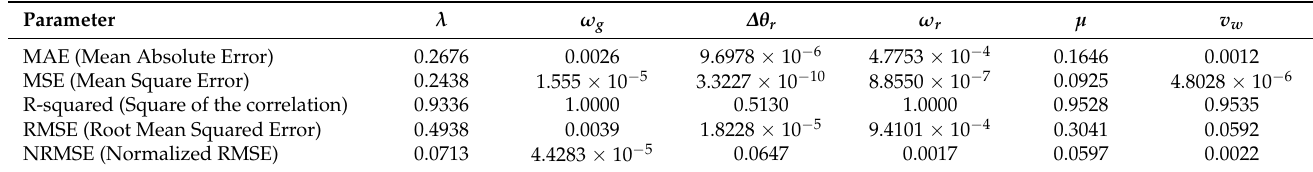
Figure 15. Time series of the rotor speed. Table 4. Quantitative evaluation of the model and observer